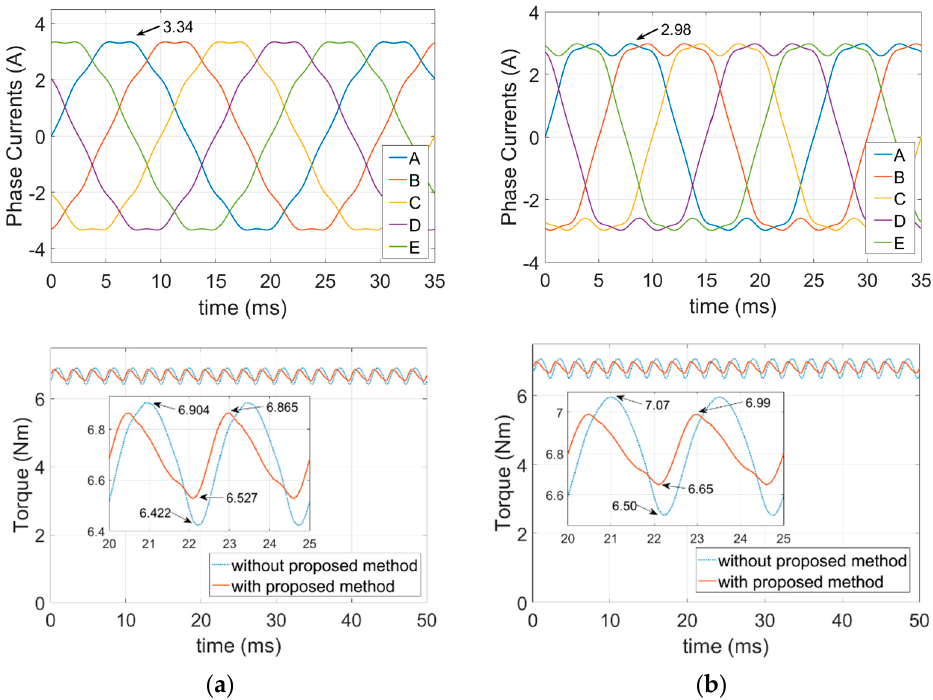
Figure 11. FEA torque waveforms for the Healthy2 condition with and without proposed method: ( a ) Only fundamental; ( b ) fundamental plus third harmonic.